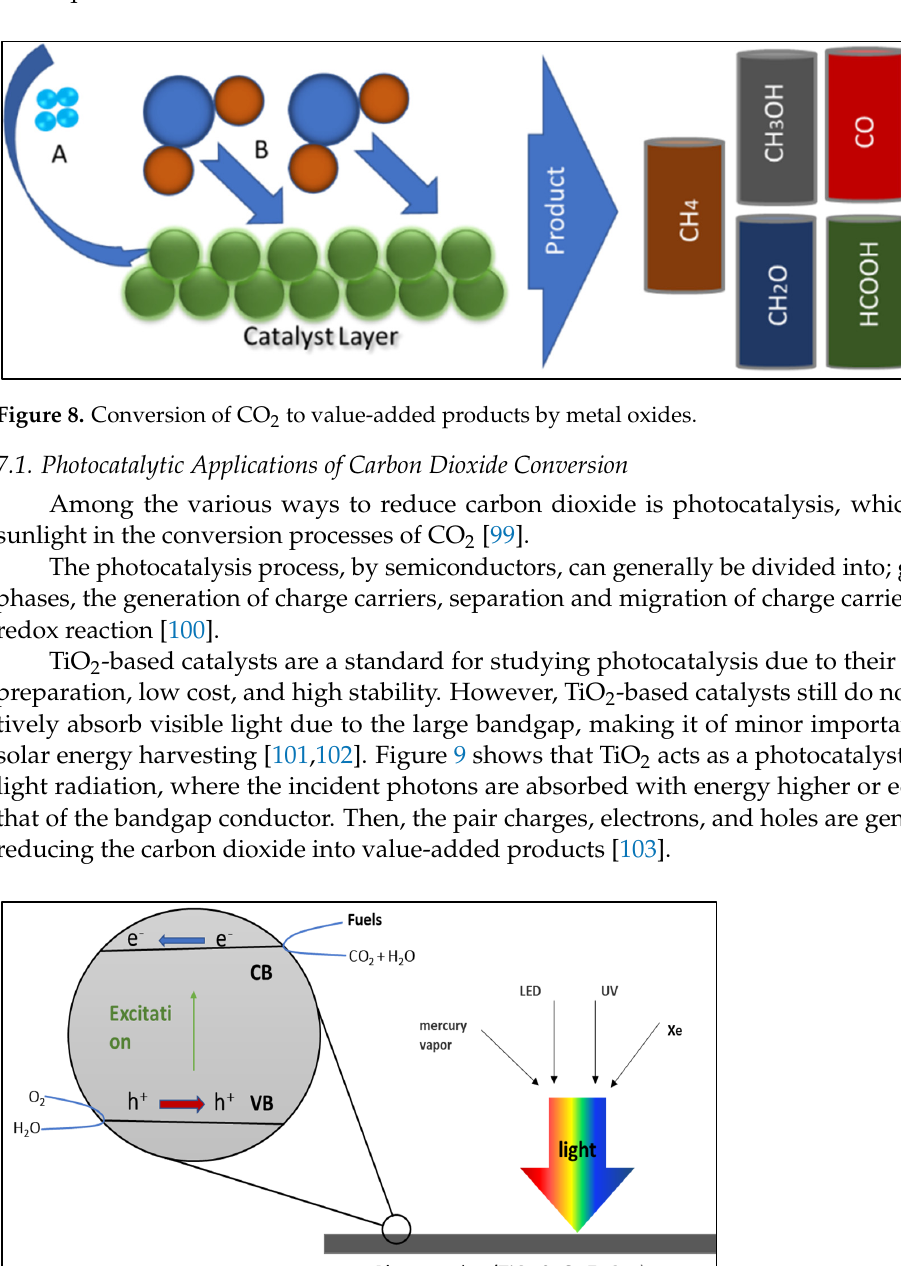
2 into fuels on the